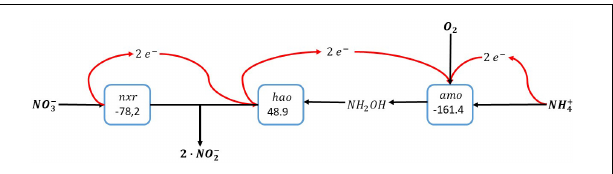
FIGURE 4 | Ammonia oxidation with combined use of oxygen and nitrate as electron acceptors. The individual blocks represent enzymatic steps ( nxr , nitrite oxidoreductase; amo , ammonia monooxygenase; hao , hydroxylamine dehydrogenase), and the corresponding Gibbs free energy change ( (cid:52) G 0 (cid:48) ) of the reactions corrected for a pH of